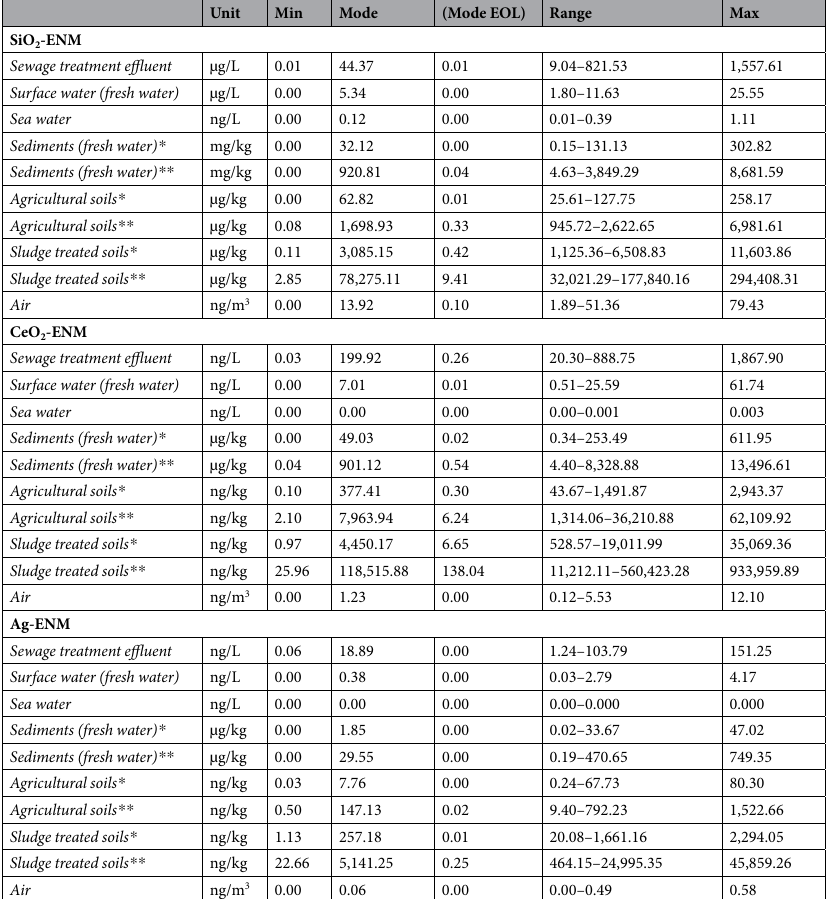
Table 4. PECs for 2017 for SiO 2 − , CeO 2 − , and Ag-ENMs. Shown are the most frequently modeled (mode) values; modes that only reflect concentrations from end of life (EOL) releases; ranges (range with some